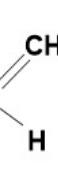
Figure 1. The basic unit of terpenes is the five-carbon isoprene (2-methyl-1,3-butadiene).